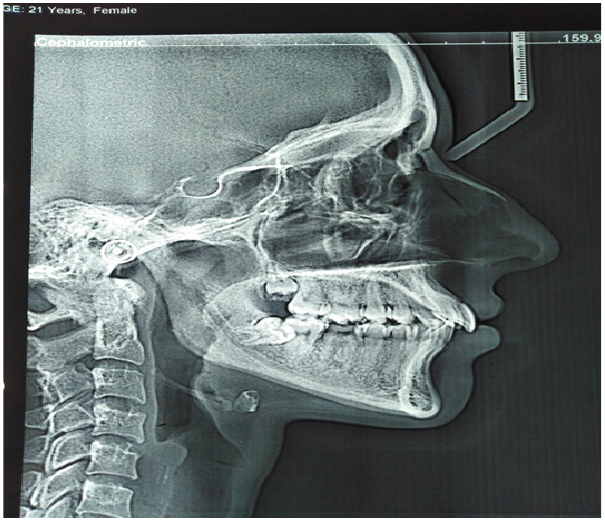
Figure-I: Lateral